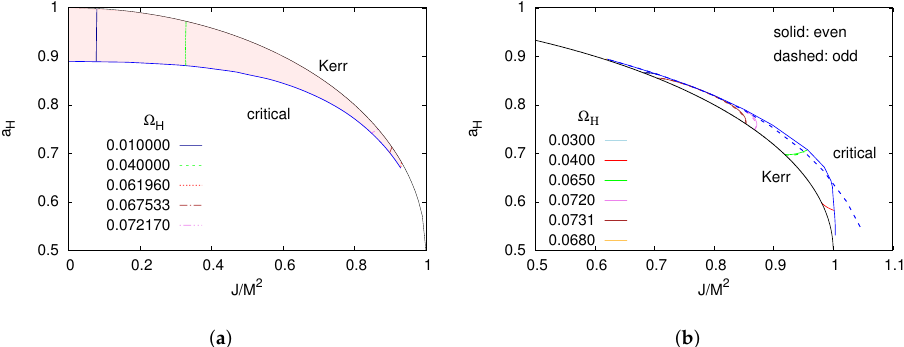
Figure 10. Domain of existence of rotating spontaneously scalarized GB black holes with quadratic coupling function: ( a ) scaled horizon area a H = A H /16 π M 2 vs. scaled angular momentum j = J / M 2 for positive coupling constant; ( b ) a H = A H /16 π M 2 vs. j = J / M 2 for spin-induced black holes for negative coupling constant, both for even and odd scalar field. The domains are delimited by Kerr black holes, and critical solutions. Additionally shown are curves of fixed horizon angular velocity Ω H